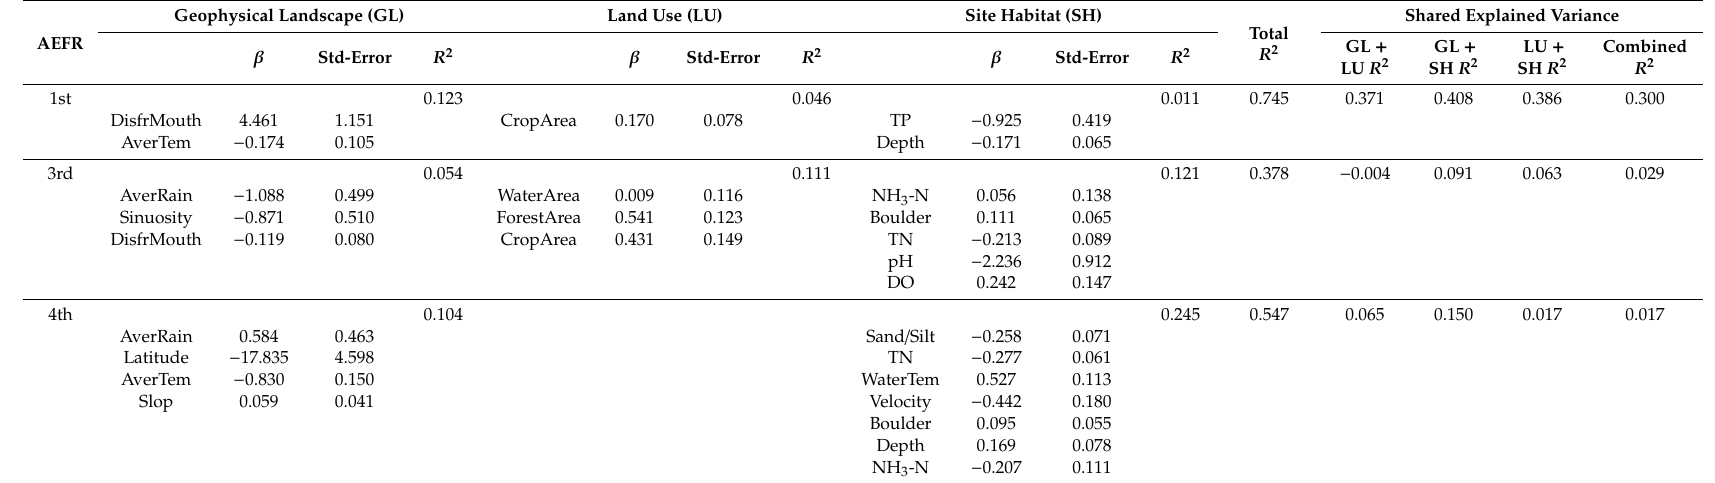
Table 4. Partial linear regression for macroinvertebrate richness and all environmental variables and shared explained